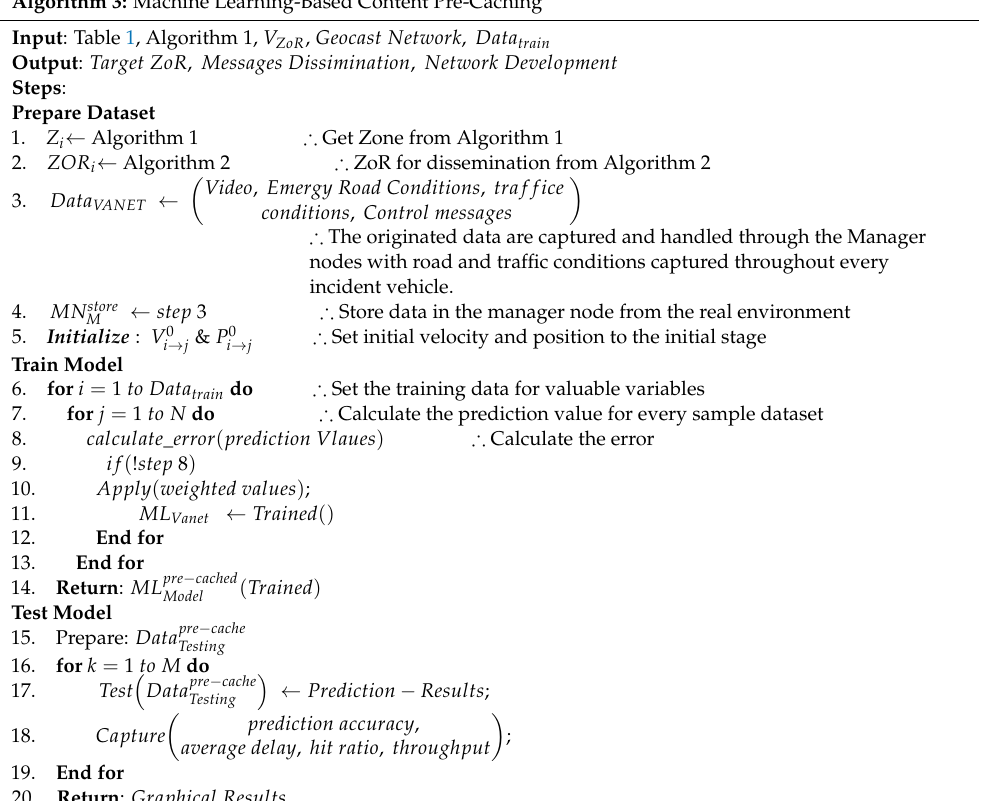
Algorithm 3: Machine Learning-Based Content